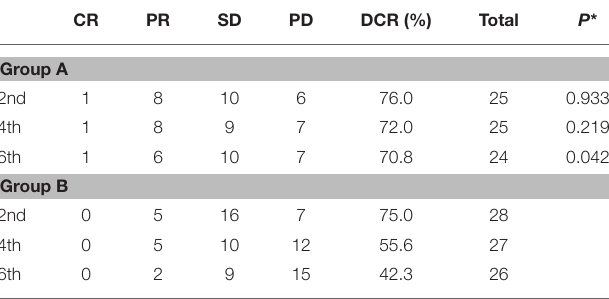
TABLE 4 | Treatment-related complications in two